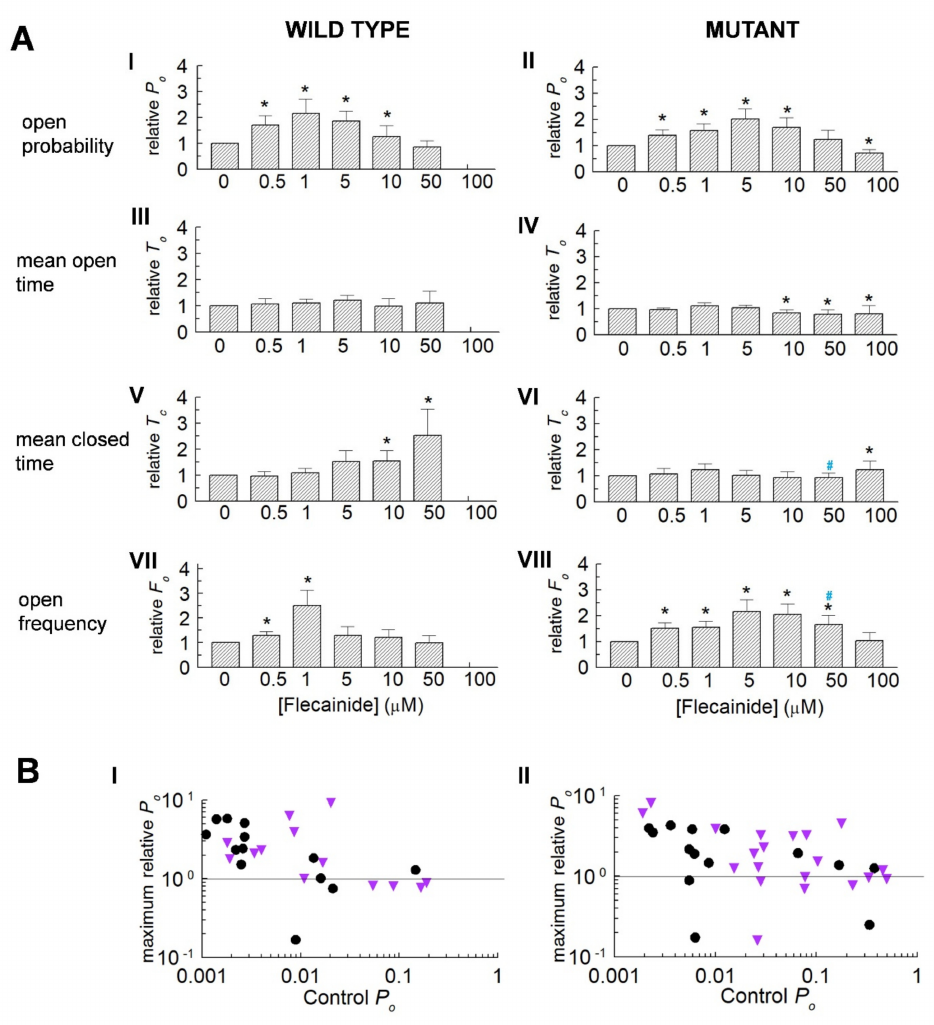
Figure 2. Actions of flecainide on relative parameter values for wild type (WT) and P2328S RyR2 channels. ( A ) Average normalised data (mean ± SEM) for WT ( n = 13) and P2328S ( n = 17) channels. Relative open probability ( P o ) ( A ) (I,II), mean open time ( T o ) ( A ) (III,IV), mean closed time ( T c ) ( A ) (V,VI) and open frequency ( F o ) ( A ) (VII,VIII). Asterisks (*) indicate significant ( p < 0.05) changes from control. Blue # indicates significant ( p < 0.05) differences between P2328S and WT. ( B ) Individual maximum relative P o values with flecainide, plotted against control P o for WT ( B ) (I) and P2328S ( B ) (II). Black circles, +40 mV; purple triangles, − 40 mV. Maximum relative P o is the highest value recorded with flecainide. Values below 1 indicate no increase in activity above control, but do not reflect the full decline in